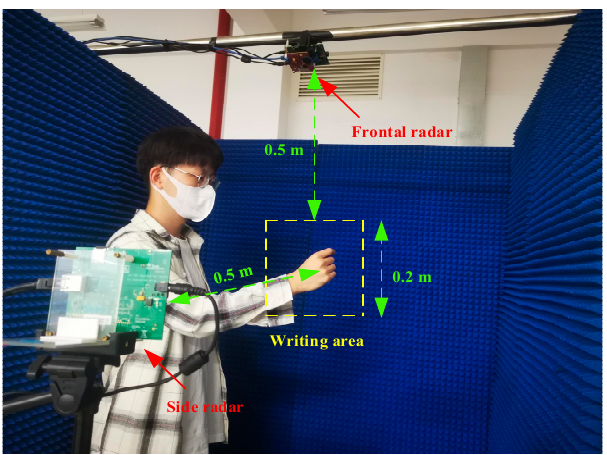
Figure 1. The test scenarios based on frontal radar and side radar.